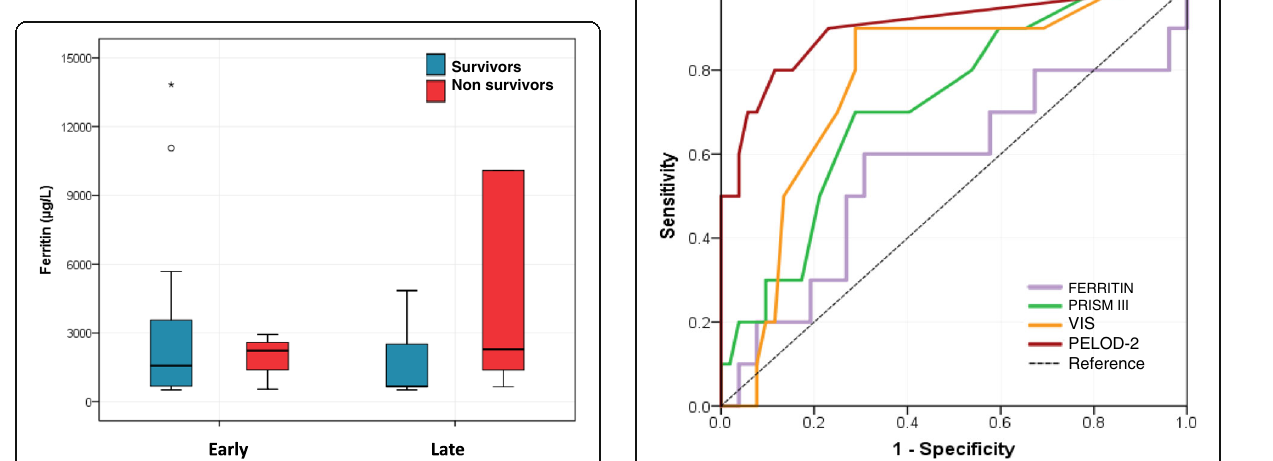
Fig. 2 Boxplot showing differences in median ferritin value between Fig. 3 Receiver operating characteristic curve comparing ferritin, PELOD 2 score, and VIS for predicting